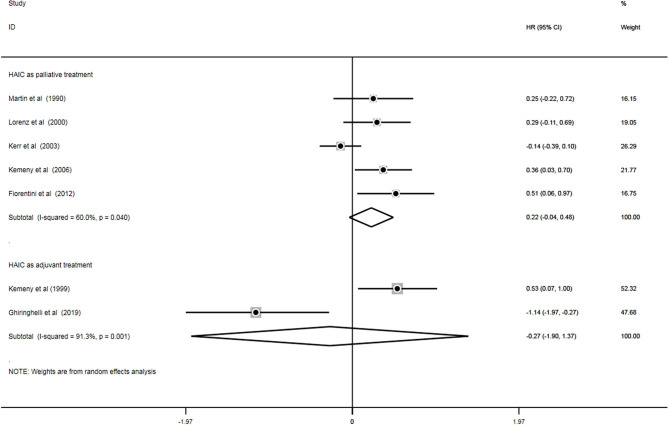
Forest plot of hazard ratios (HR) for progression-free survival (PFS).